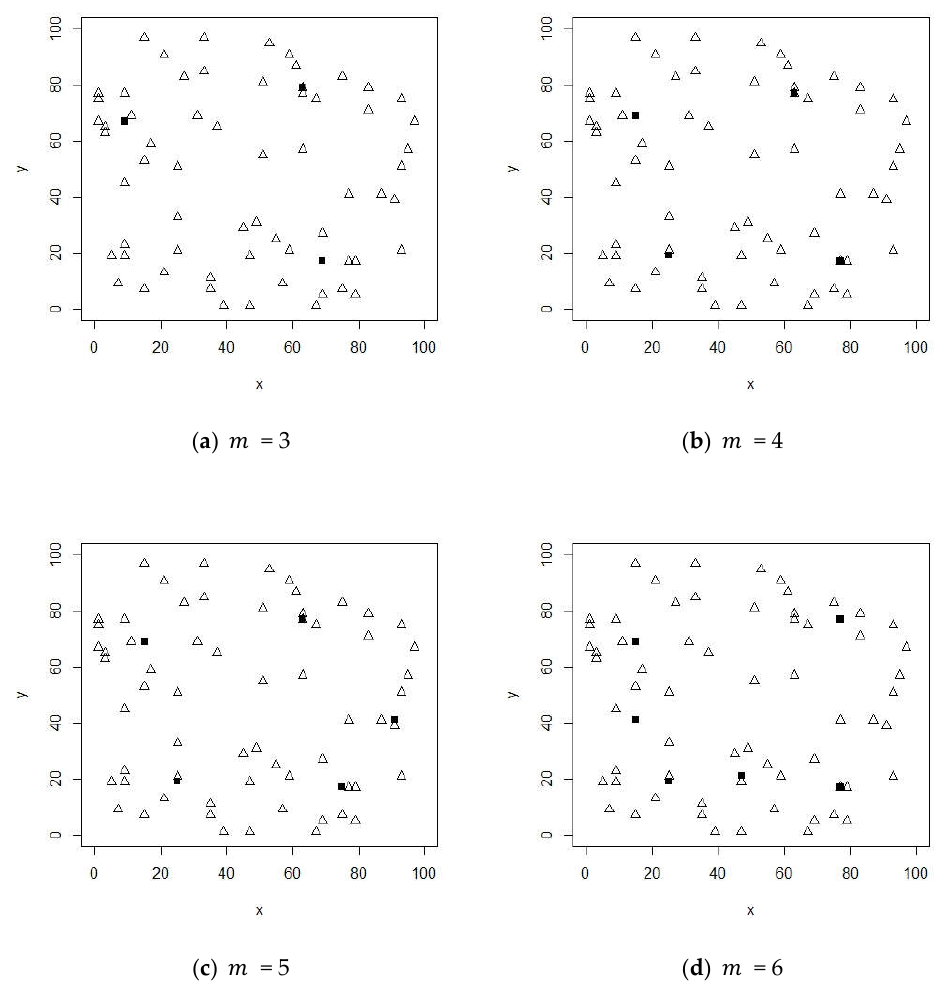
Figure 4. Globally optimal facility locations in the planning area for Instance 25. ( a ) m = 3; ( b ) m = 4; ( c ) m = 5; ( d ) m = 6.